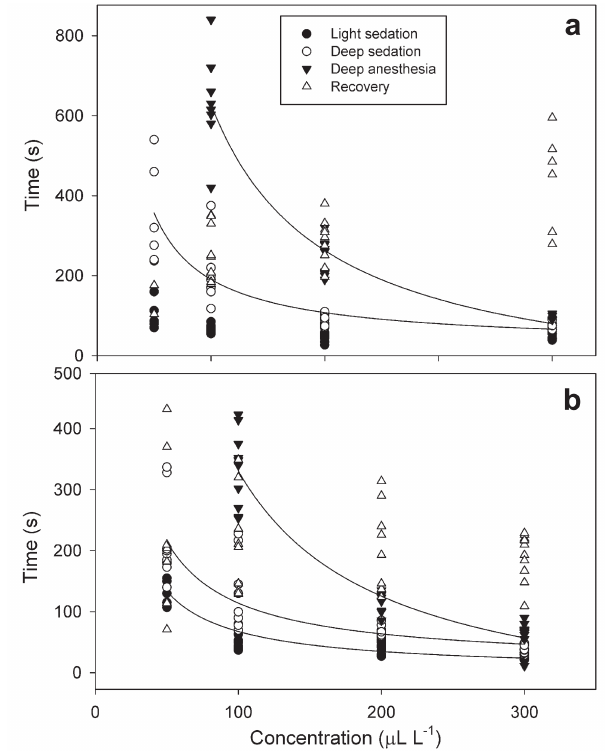
Fig. 1. Relationships of concentration x anesthesia induction or recovery time in tambaqui, Colossoma macropomum , exposed to the essential oils. a. Aniba rosaeodora (EOAR); deep sedation: y=24.8+(8300/x), r 2 =0.705, deep anesthesia: y=-102.3+(36527/x), r 2 =0.913. Light sedation and recovery: no significant relationship. b. Aniba parviflora (EOAP); light sedation: y=2.08+(6563/x), r 2 =0.832, deep sedation: y=13.2+(10098/x), r 2 =0.703, deep anesthesia: y=-79.8+(41067/x), r 2 =0.906. Recovery: no significant relationship. y = time to reach stage or recovery (s) and x = concentration (µL L -1 ).